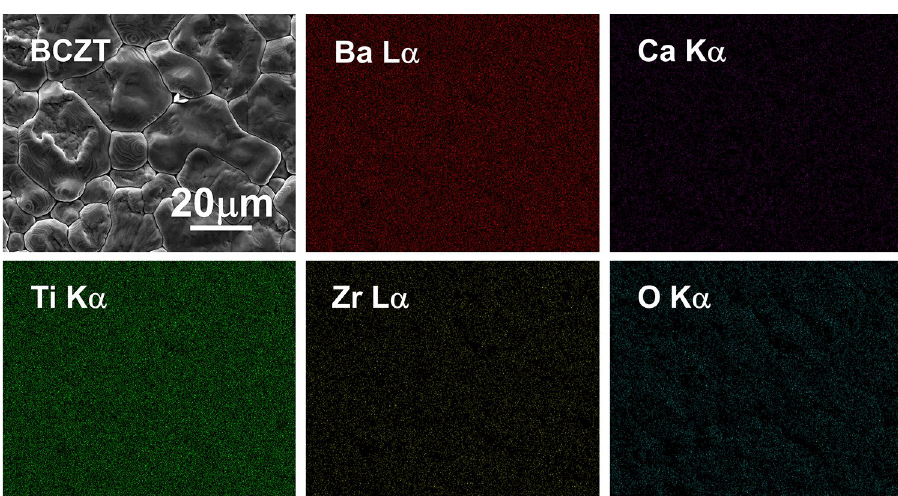
Figure 7. SEM image and EDS spectra of MSGH-derived BCZT ceramic sintered at 1400 °C.